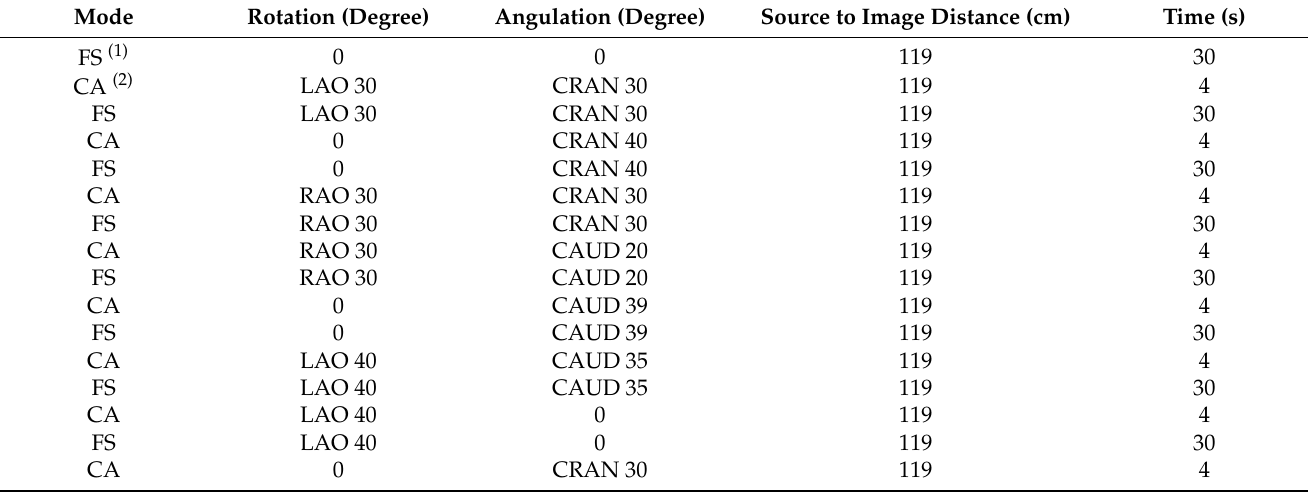
Figure 1. The simulated arrangement of interventional cardiologists and patients for cardiac angiography to X-ray angulation. The position of cardiologist, patient, and X-ray tube angulation showed in each procedure. Table 1. The cardiac angiography exposure condition for Monte Carlo simulation and phantom study. X-ray tube rotation and angulation, distance from X-ray source to image detector, and exposure time showed in each procedure.